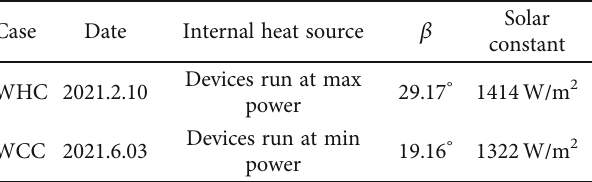
Table 1: WHC and WCC parameters.